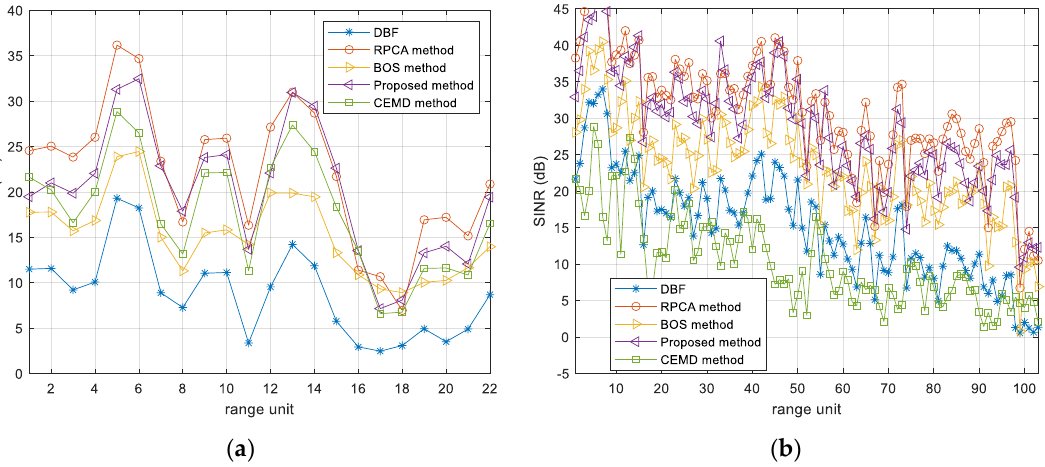
Figure 10. The SINR improvements of STI mitigation in range domain: ( a ) Negative − frequency sea echo of the STI; ( b ) Positive − frequency sea echo of the STI.